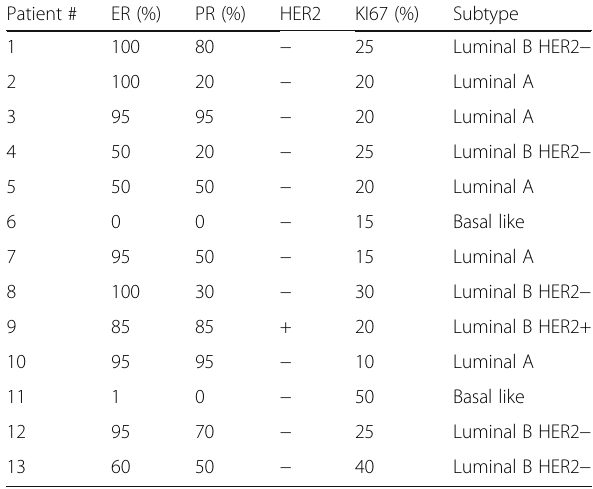
Table 4 Receptor expression profile of primary breast cancers including estrogen receptor (ER), progesterone receptor (PR) status, HER2/neu status, and Ki67 proliferation